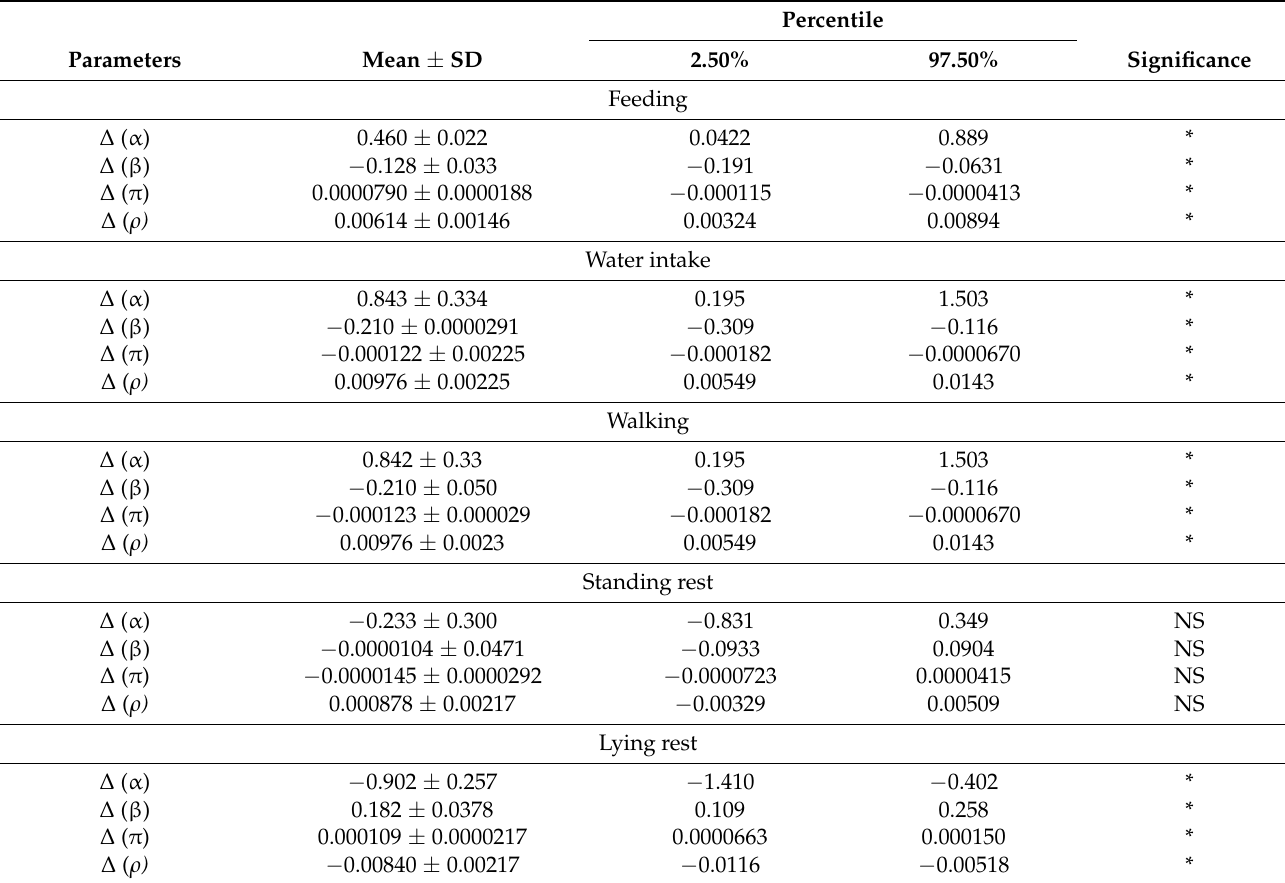
Table 4. A posteriori estimates of parameters (mean ± standard deviation and credibility intervals) of primiparous and multiparous cow behaviour.